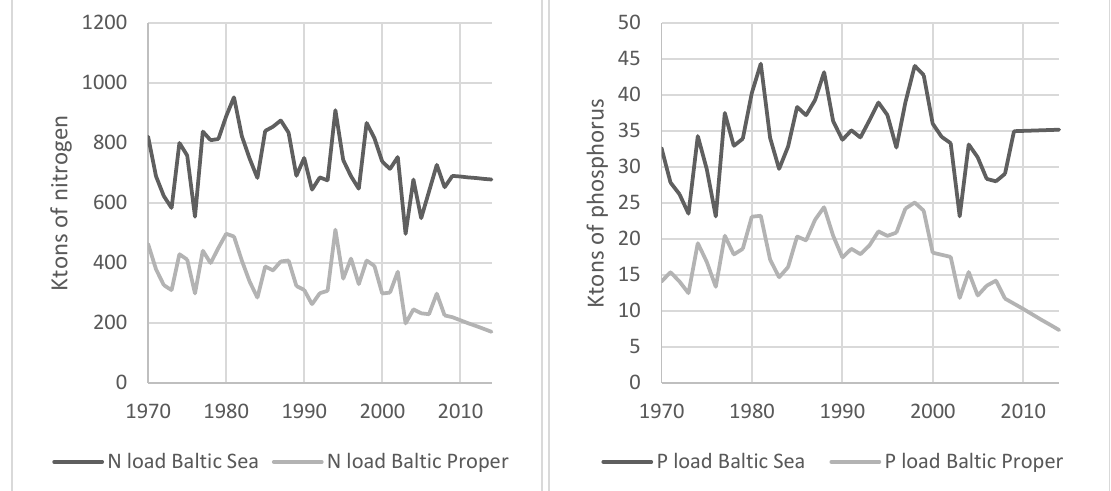
Fig. 2. Loads (ktons) of (left) nitrogen (N) and (right) phosphorus (P) to the Baltic Sea and the Baltic Proper, 1970-2014